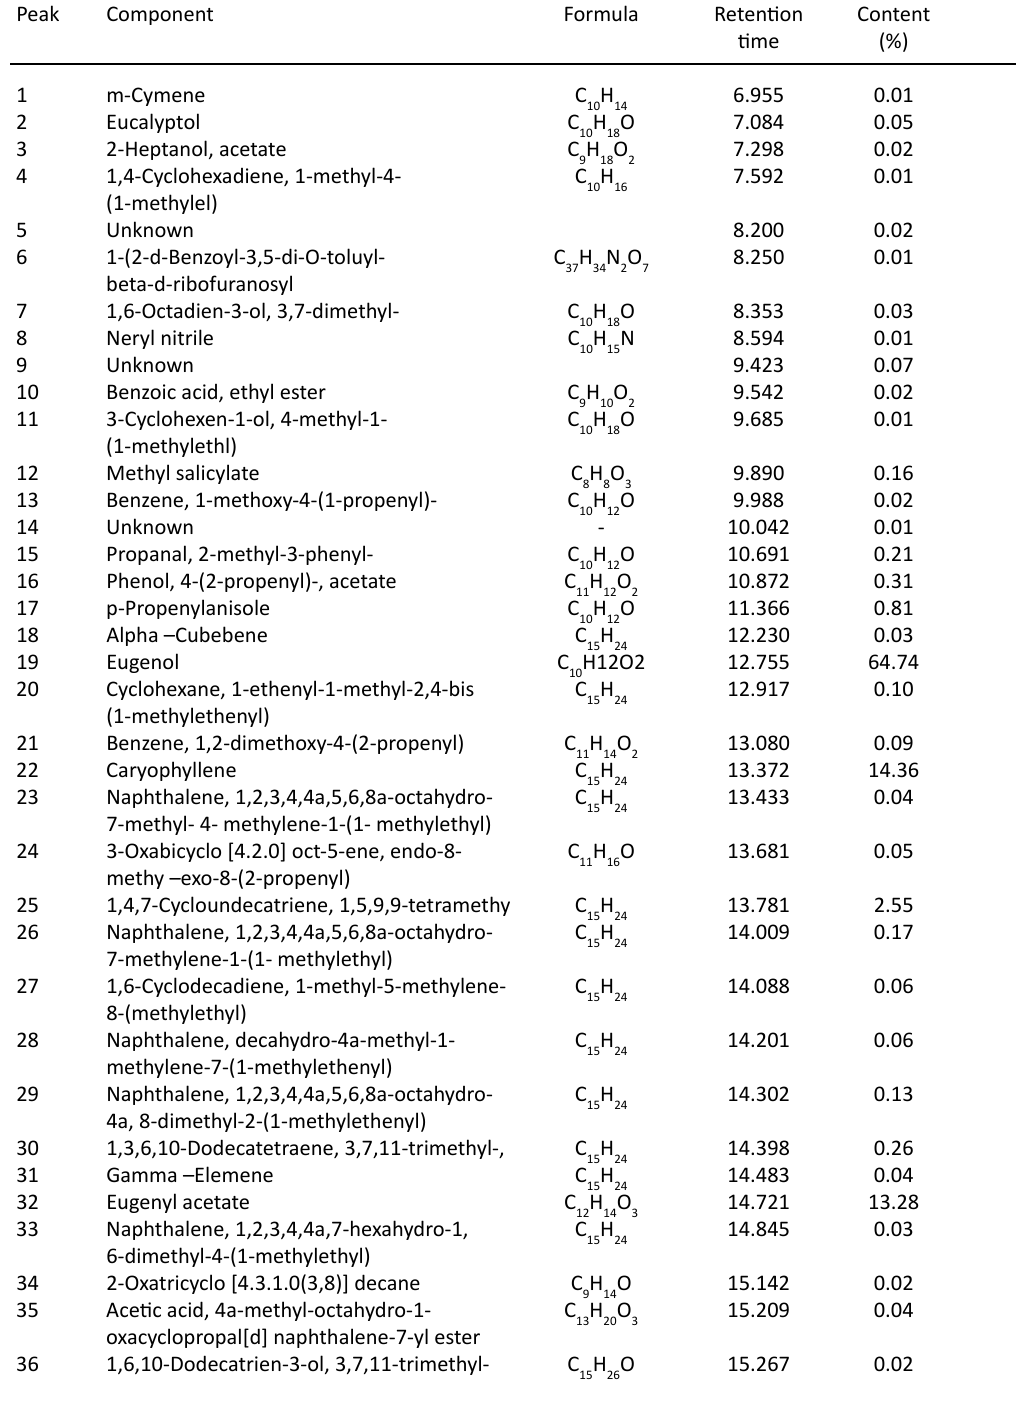
Table 1. Compounds identified in the essential oil of Syzygiumaromaticum seeds using gas chromatography mass spectrometry